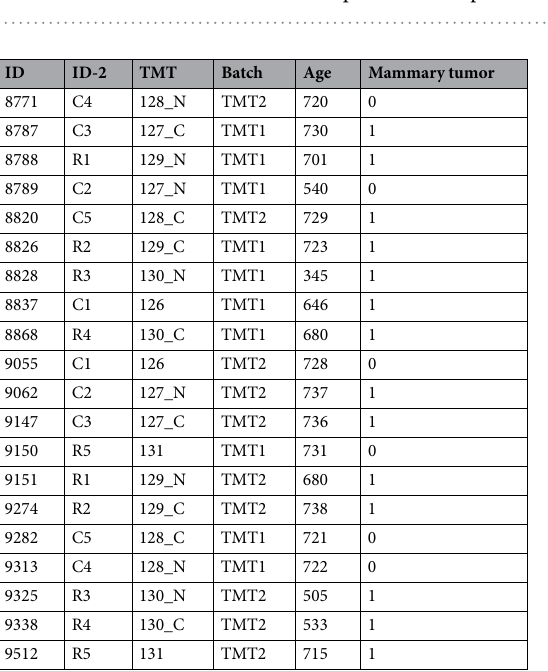
Figure 1. Increased plasma triglyceride levels in rats administered with Roundup. Blood samples was collected from control and Roundup-treated (50 ng/L glyphosate equivalent dilution) female rats following two years exposure via drinking water. Blood was taken via the tail vein of each animal after 1, 2, 3, 6, 9, 12, 15, 18, 21 and 24 months of treatment. Pair-wise comparisons were performed with a Mann-Whitney U test.